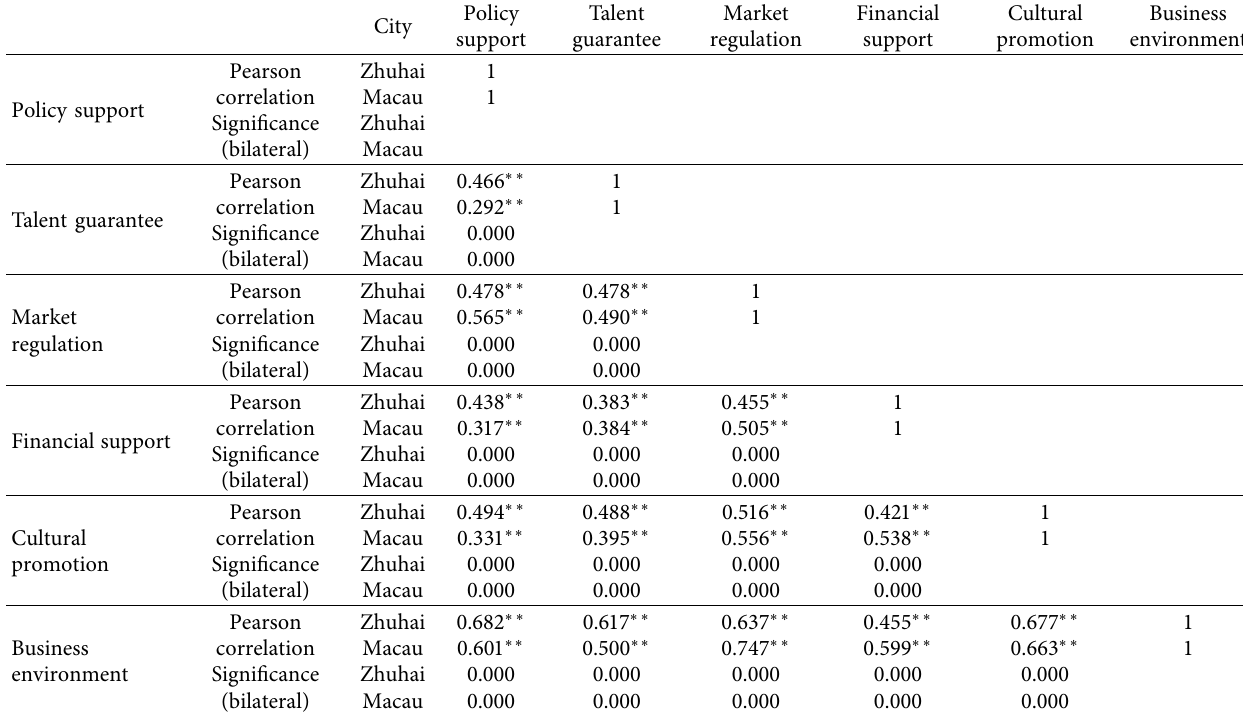
Table 7: The correlation analysis between variables was conducted in Zhuhai and